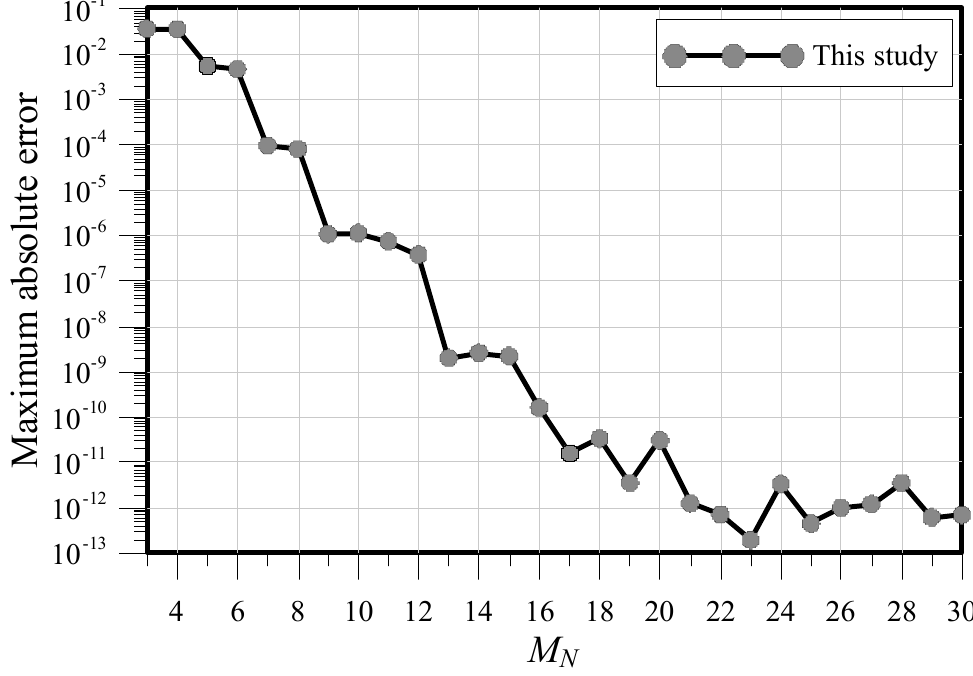
Figure 8. The number of terms of the radial polynomial basis function versus maximum absolute error.